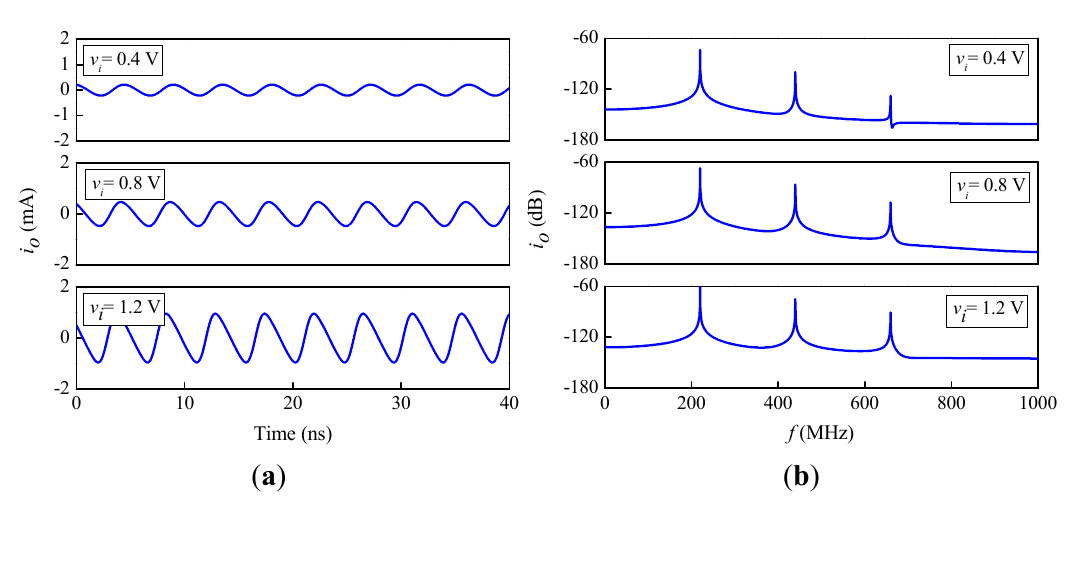
Figure 10. ( a ) The time-histories and ( b ) Fast Fourier transforms for EWG ring resonator with f = 220 MHz, Q = 8,000, d = 90 nm and V